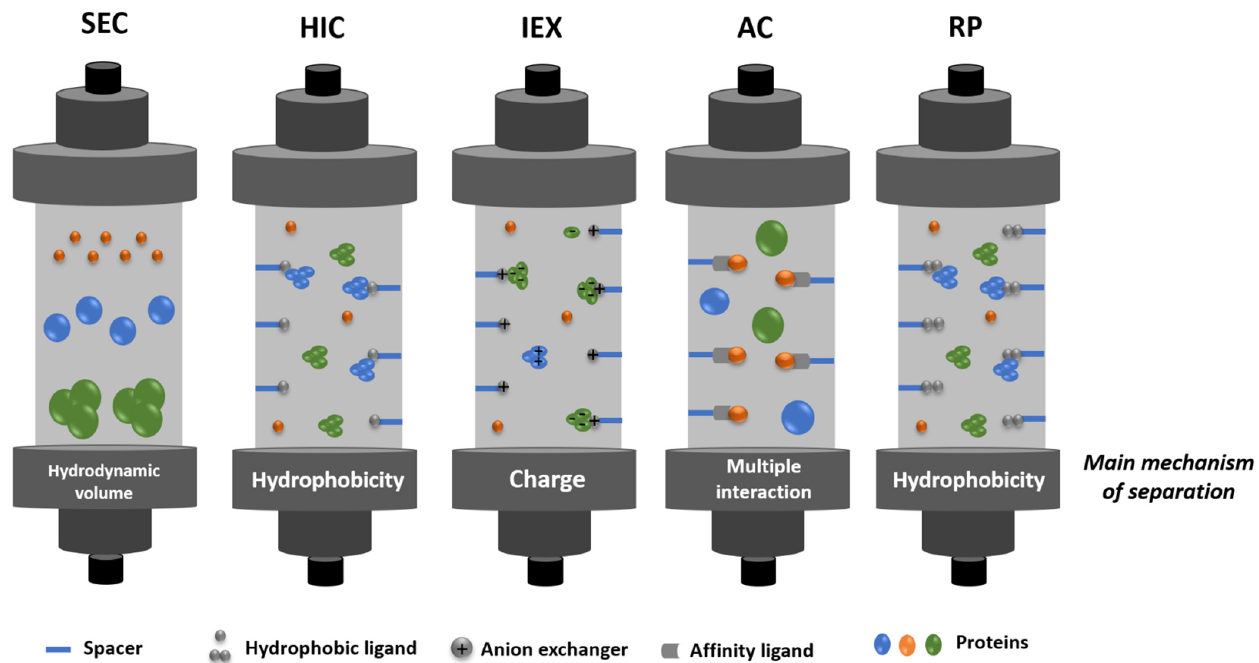
Figure 7. Separation principles of distinct types of chromatographic techniques applied for the isolation and purification of IFNs (SEC–Size exclusion chromatography, HIC–Hydrophobic interaction chromatography, IEX–Ion-exchange chromatography, AC–Affinity chromatography, RP–Reverse phase chromatography).